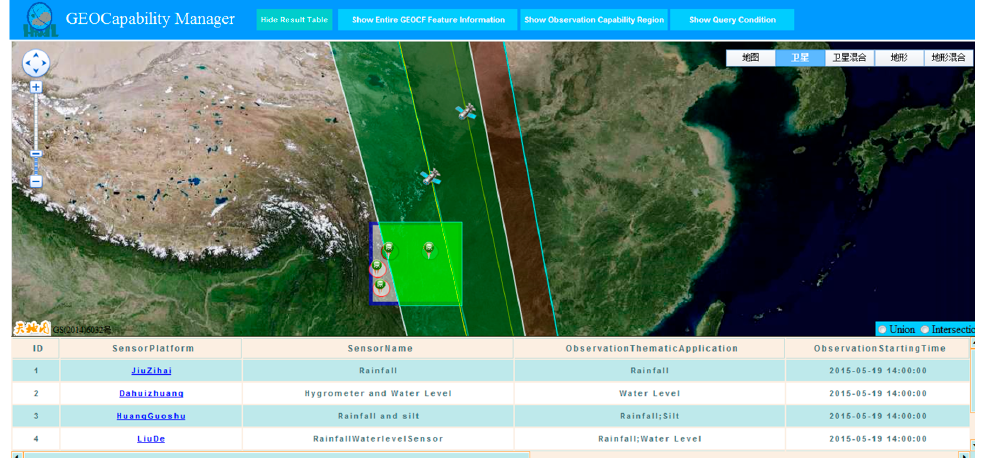
Figure 10. Discovered sensors for the given flood observation task.